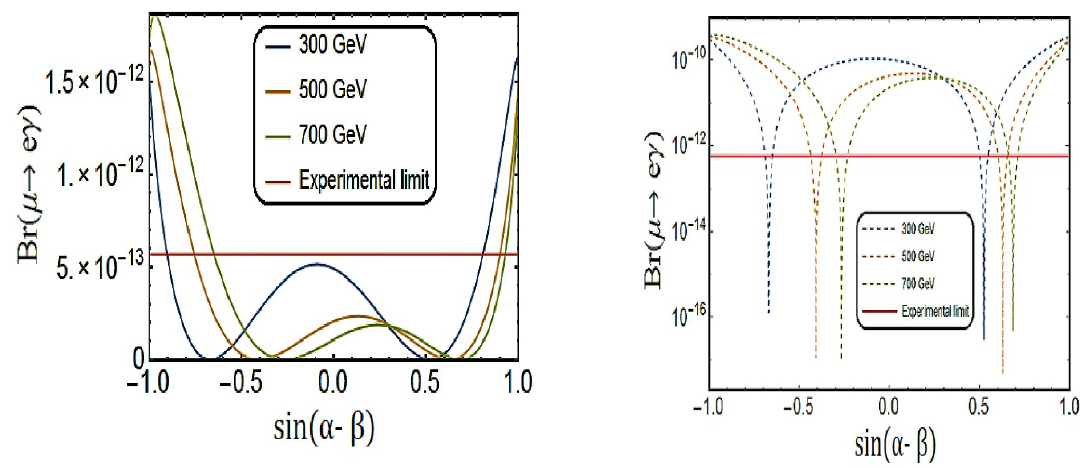
Figure 3 . Branching ratio Br ( (cid:22) ! e(cid:13) ) as a function mixing sin( (cid:11) (cid:0) (cid:12) ) in two scenarios: Left: our modi(cid:12)ed ansatz where amplitude goes as m e , Right: Cheng-Sher ansatz where amplitude goes as p m e m (cid:22) . Here we set ~ Y t = 1, and C e(cid:22) = C (cid:22)e = v